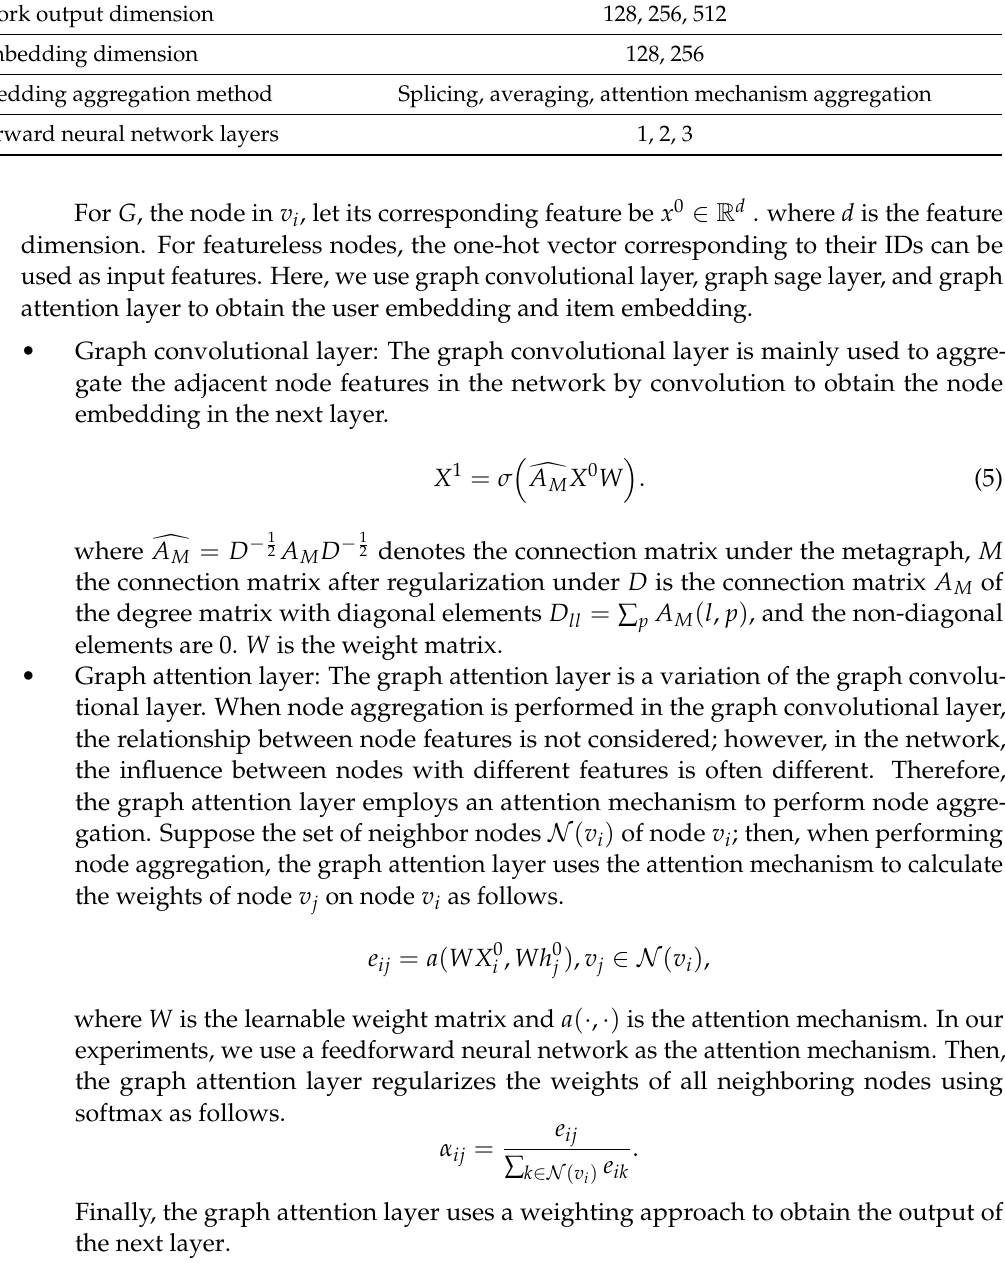
Figure neural network attention mechanism head count Figure neural network output dimension Metaplot node embedding dimension